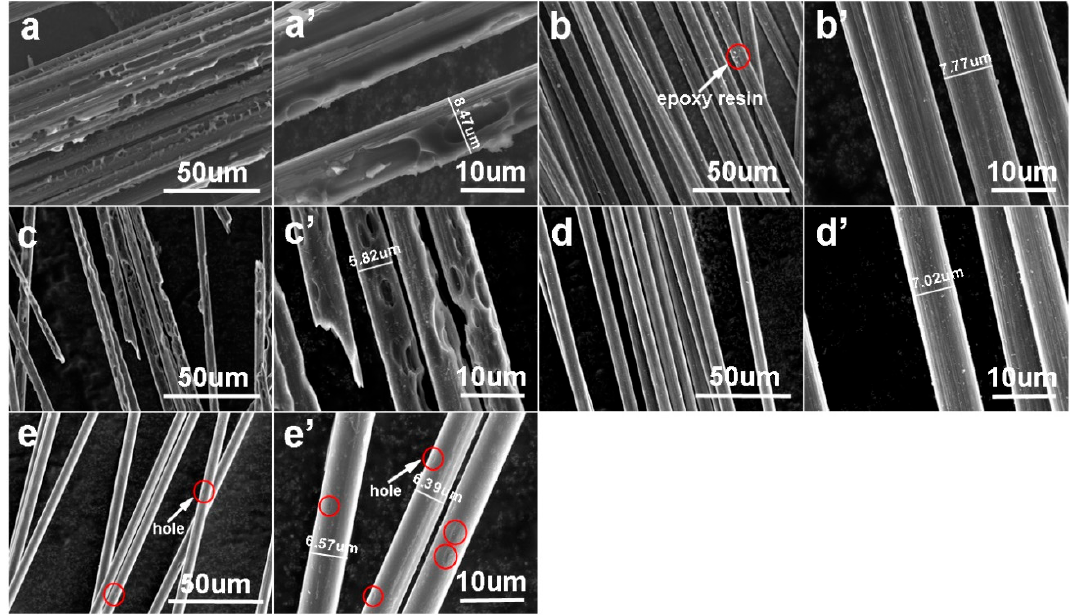
Figure 5. Field emission scanning electron microscope (FESEM) images of recovered carbon fibers: ( a ) and ( a’ ) 30 min of traditional heating at 400 °C, ( b ) and ( b’ ) 30 min of traditional heating at 450 °C, ( c ) and ( c’ ) 30 min of traditional heating at 500 °C, ( d ) and ( d’ ) 13 min of microwave heating at 450 °C, ( e ) and ( e’ ) 30 min of microwave heating at 450 °C.